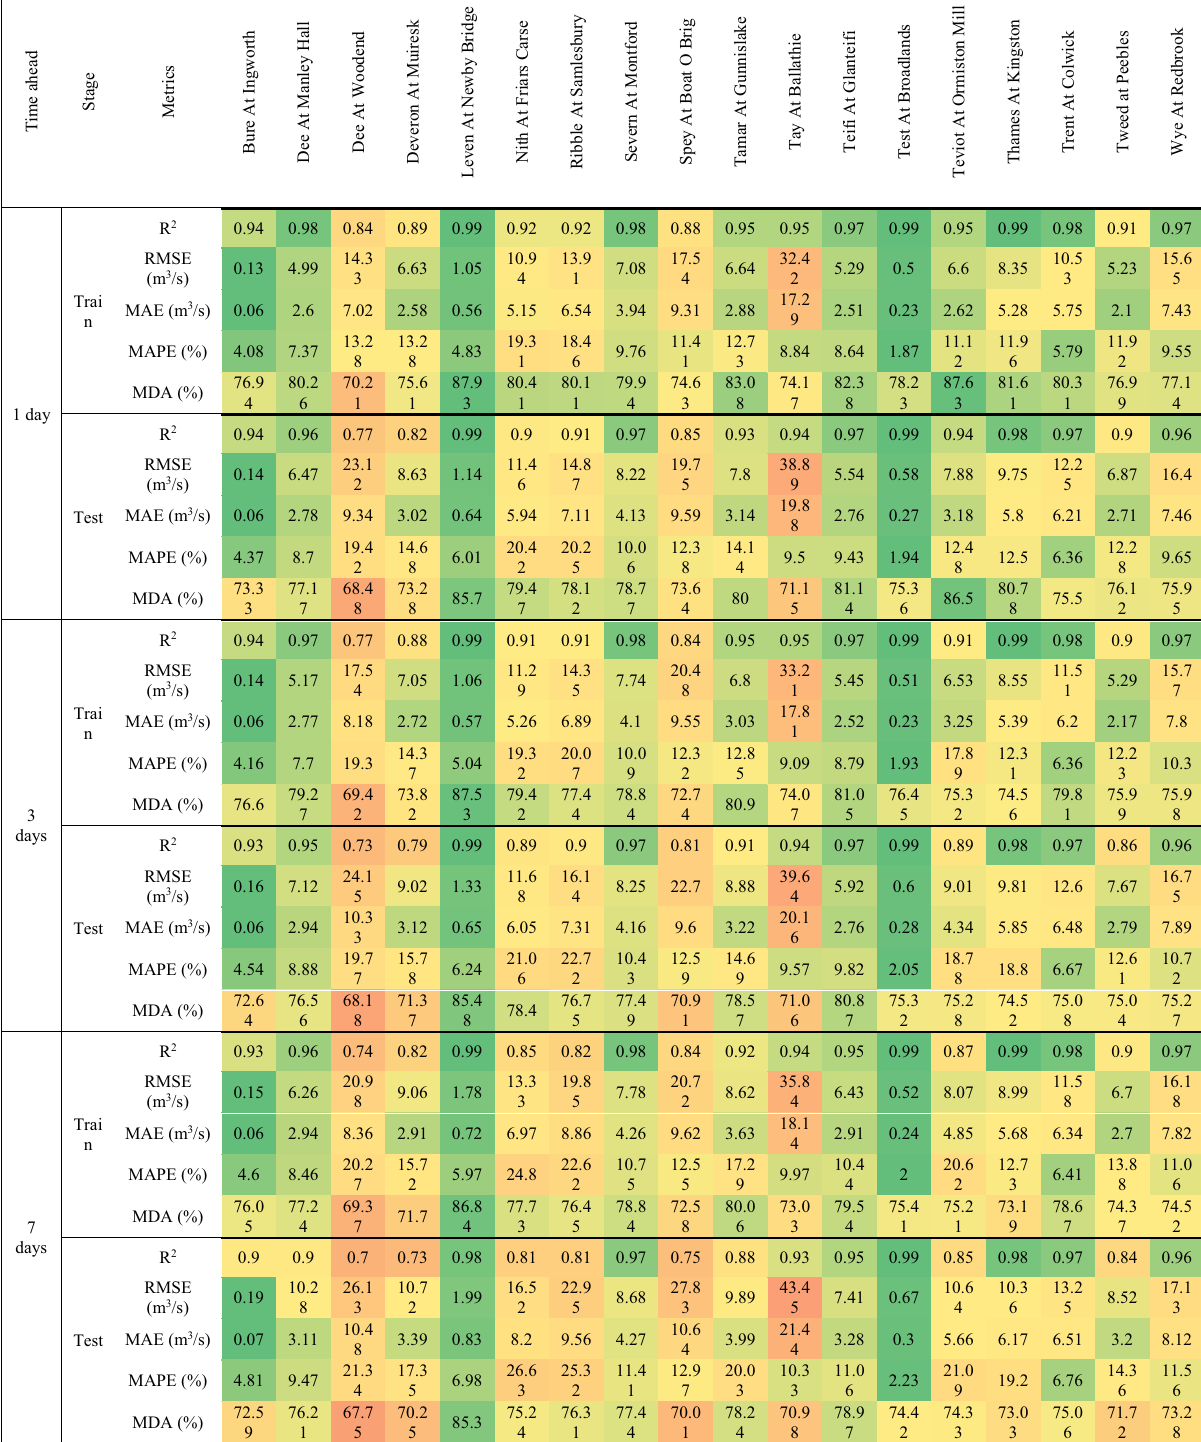
Table 5. Evaluation metrics for NARX-MLP-RF